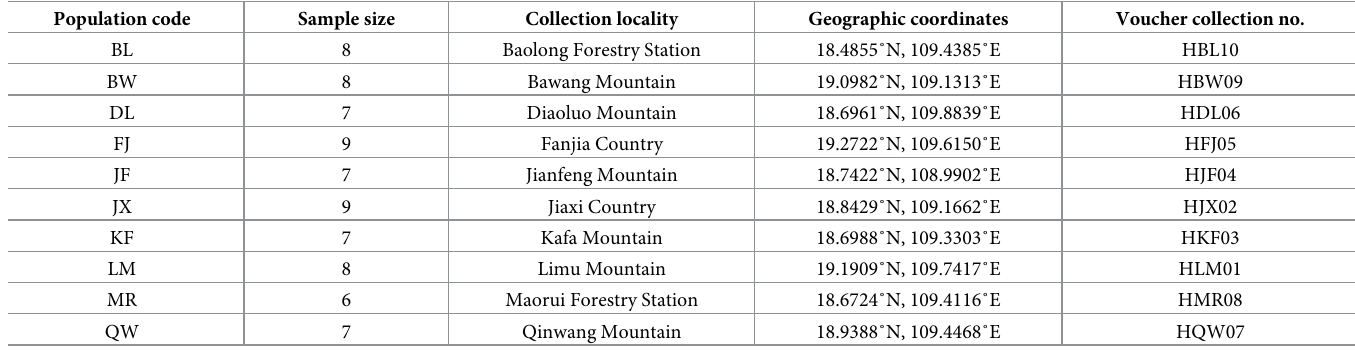
Table 1. Sampling information for Hopea hainanensis populations on Hainan Island,